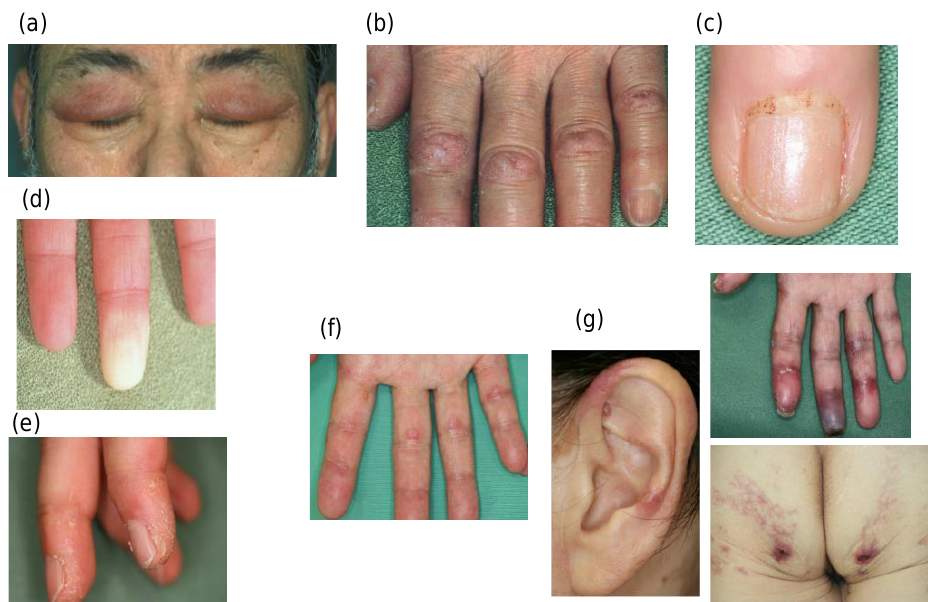
Figure 1. Skin manifestations of PM/DM. ( a ) Heliotrope rash. ( b ) Gottron’s sign. ( c ) Nail fold bleeding. ( d ) Raynaud’s phenomenon. ( e ) Anti-synthetase syndrome is often associated with mechanic’s hand. ( f , g ) Anti-MDA5 antibody-positive dermatomyositis is often associated with reverse Gottron’s sign ( f ), ulceration, and gangrene ( g